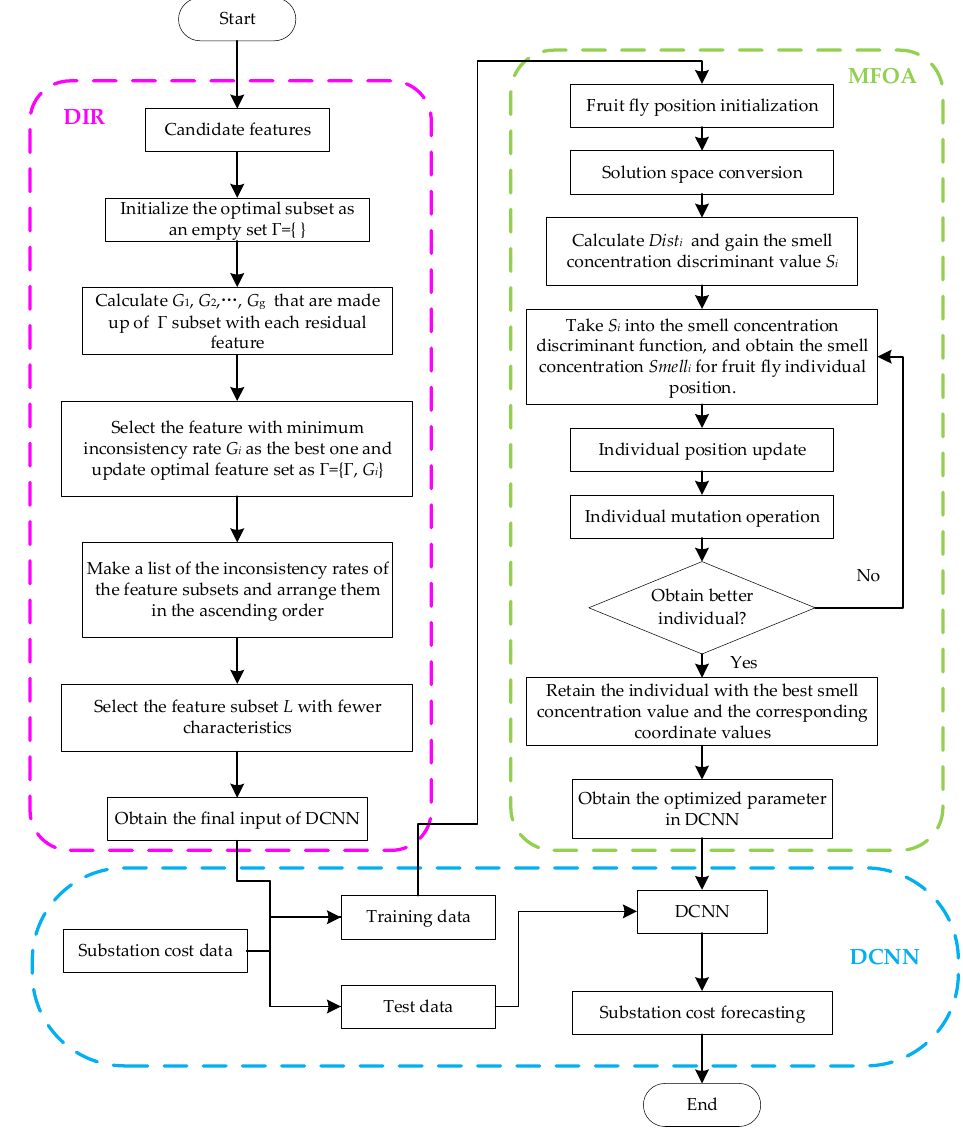
Figure 3. The flow chart of the modified fruit fly optimization algorithm– data inconsistency rate– deep convolutional neural network (MFOA–DIR–DCNN).